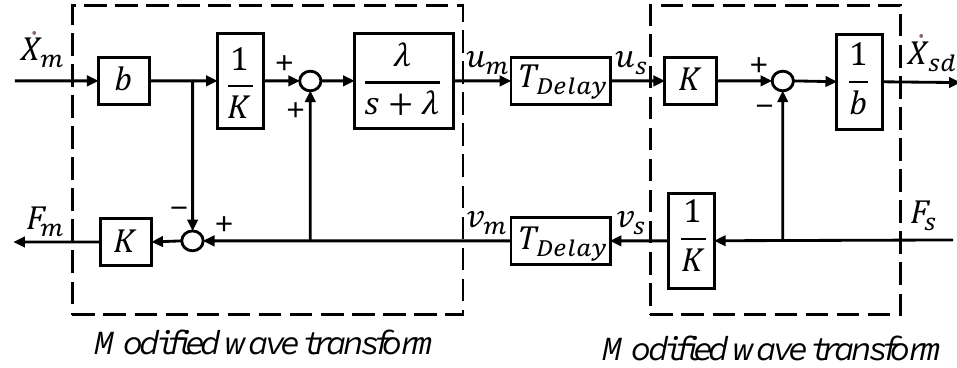
Figure 6. Modified wave variable